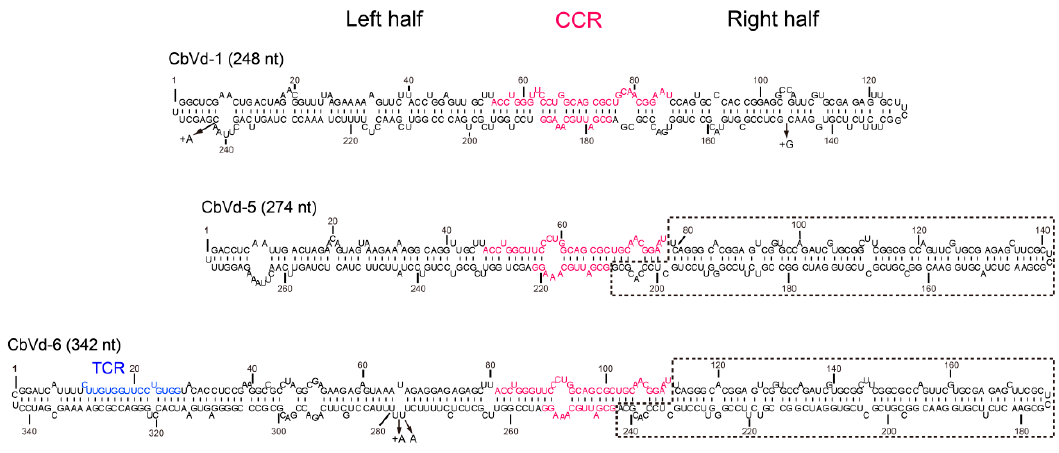
Figure 1. Predicted secondary structures of coleus blumei viroid (CbVd)-1, -5, and -6. The secondary structure of CbVd-1 refers to that determined by selective 2’-hydroxyl acylation analyzed by primer extension (SHAPE) [33]. The secondary structure of CbVd-5 and -6 was predicted based on their reference sequences, namely, FJ151371 and FJ615419, respectively. Different nucleotides between the reference sequence and infectious clone sequence are indicated by arrows. +A and +G means an A or G insertion in the corresponding position. The central conserved region (CCR) and terminal conserved region (TCR) are marked in pink and blue, respectively. Sequences shared by CbVd-5 and -6 are indicated by a dashed line.